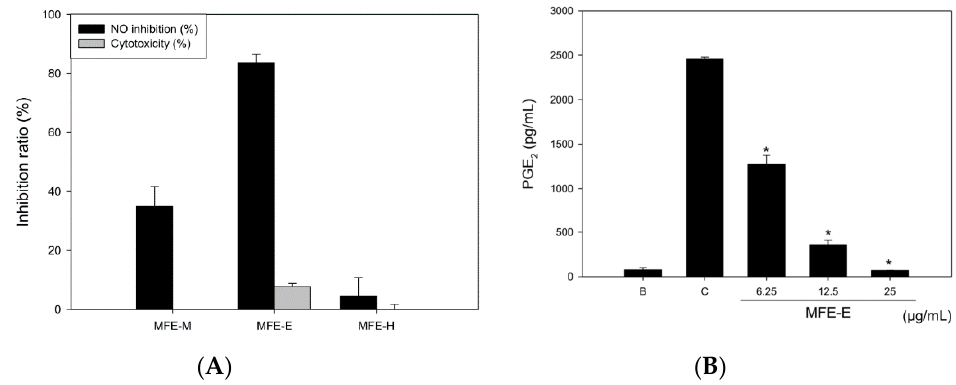
Figure 2. Effects of M. fragrans on LPS (500 ng/mL)-stimulated RAW 264.7 cells after 24 h of treatment. NO inhibition percentage of MFE-M, MFE-H, and MFE-E ( A ). PGE 2 inhibition percentage of MFE-E at various concentrations (6.25–25 µg/mL) ( B ). * p < 0.01 compared with Control; B: Blank (without LPS induction), C: Control (LPS induction without MFE-E treatment).